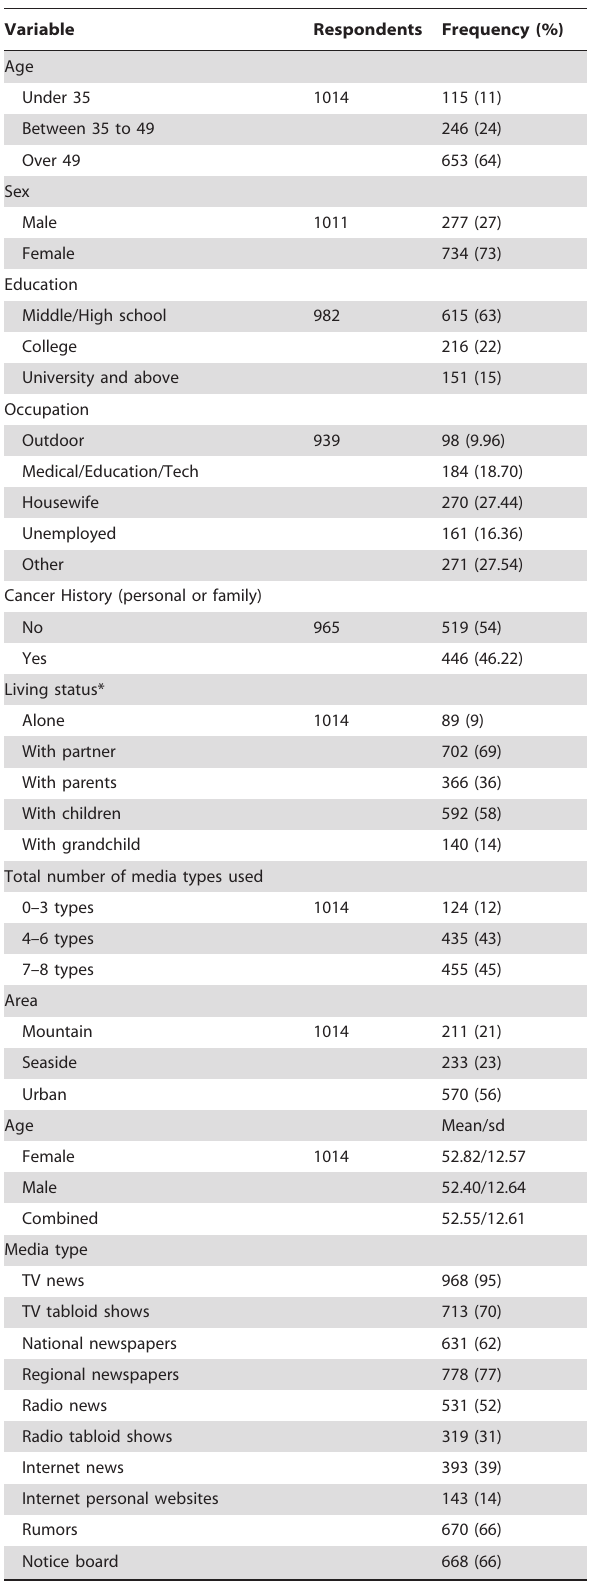
Table 1. Respondent demographics and media